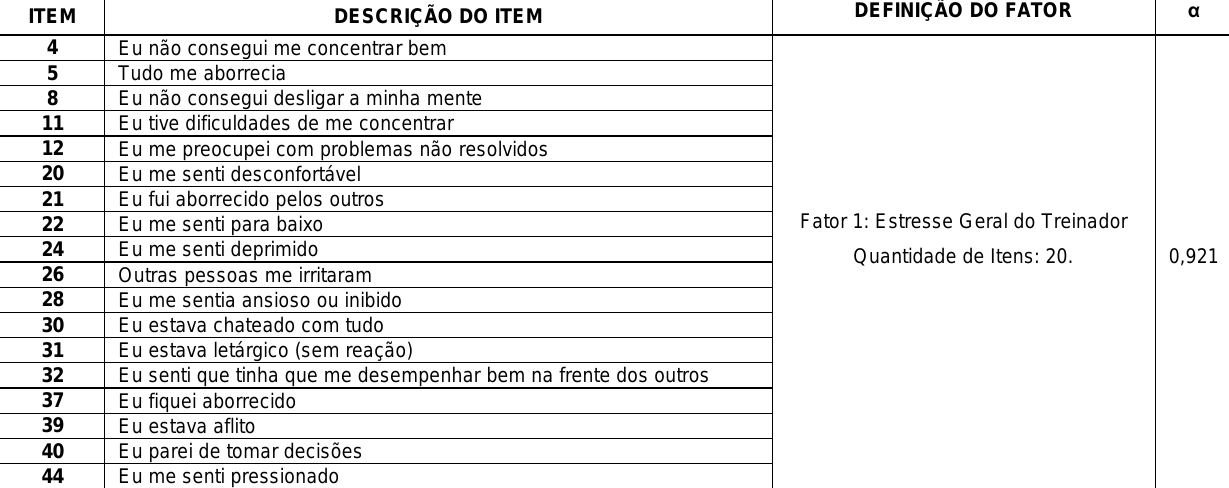
Fator 1: Estresse Geral do Treinador Quantidade de Itens: 20.